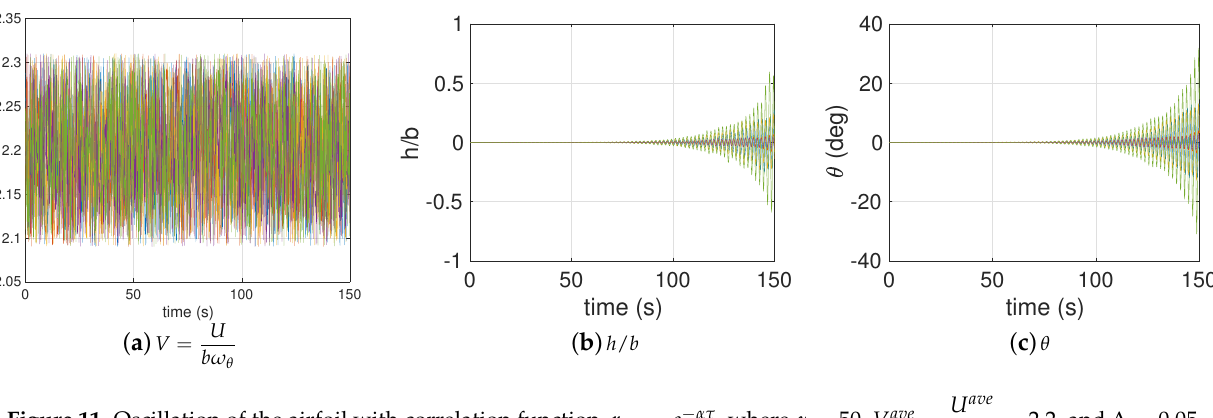
U ave = 2.2, and ∆ = 0.1. b ω θ